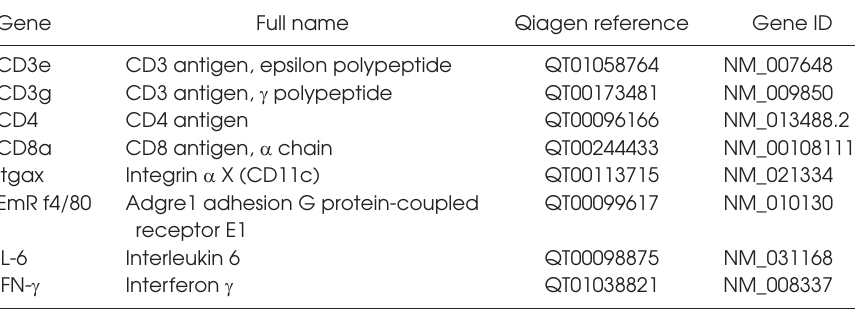
Table 1. Primers purchased from Qiagen.